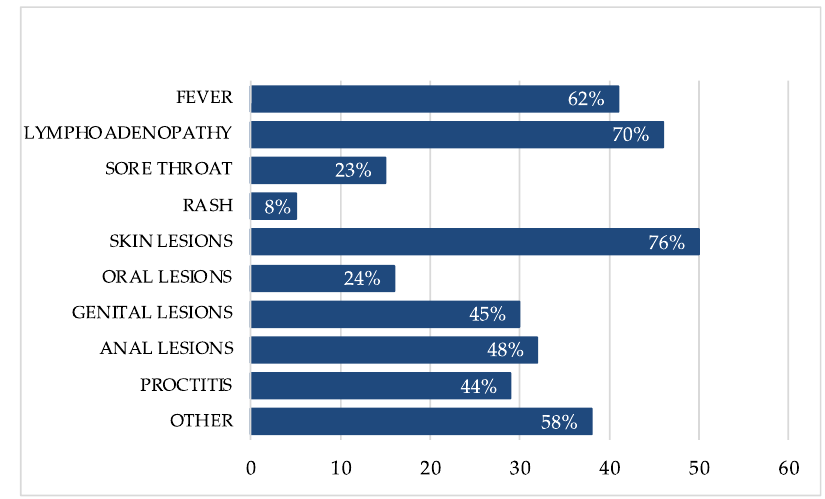
Figure 4. Symptoms of mpox in people living with HIV (PLWH).